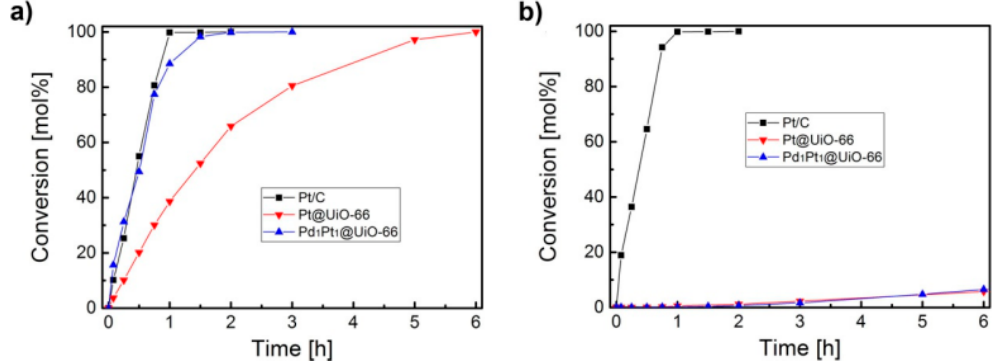
Figure 13. Time–conversion plot of ( a ) nitrobenzene and ( b ) 3,5-dimethylnitrobenzene using Pd 1 Pt 1 @UiO-66(Zr), Pt@UiO-66(Zr) and Pt/C as catalysts. Reproduced with permission from [62].